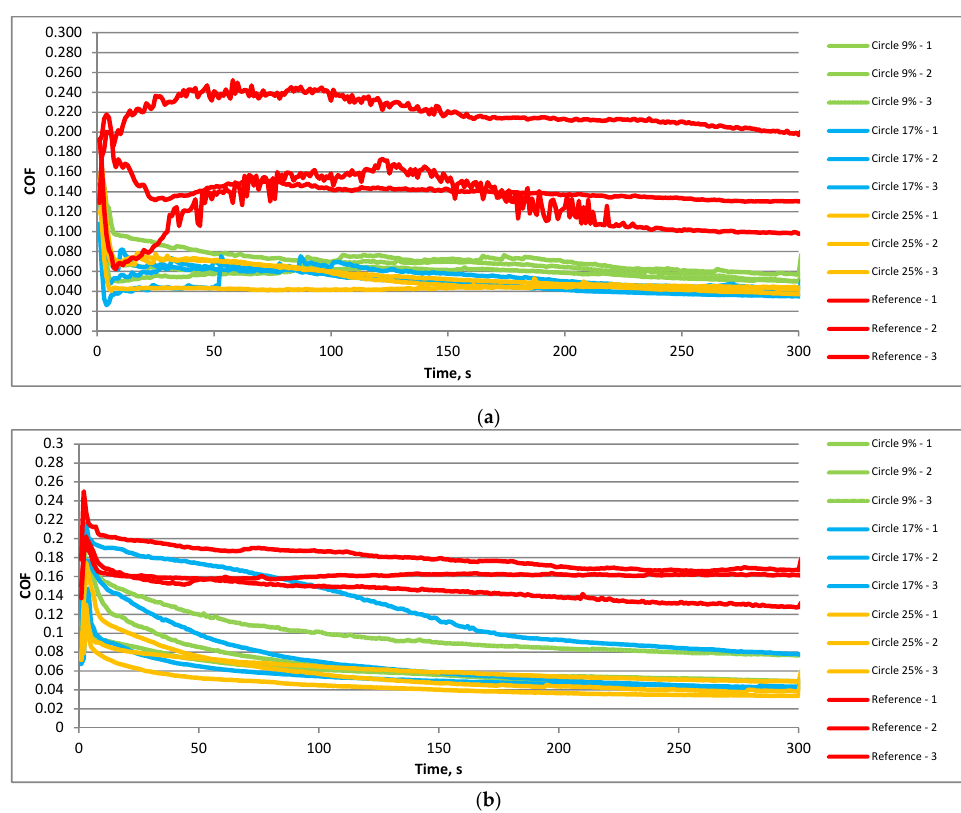
Figure 6. Courses of the coefficient of friction in the following operating conditions: f = 20 Hz; F = 40 N; T = 30 °C ( a ) and f = 20 Hz; F = 80 N; T = 30 °C ( b ). Figure 7 shows the coefficient of friction versus time for textured and untextured assemblies under a higher frequency of oscillation of 40 Hz at a lower temperature of 30 °C. Similarly to working at higher temperatures, an increase in frequency led to an increase in duration of the initial fluctuation of about 30 s, independent of the normal load. For both normal loads, the highest value and the variation of the friction coefficient were obtained for an untextured sliding pair. When textured disc samples were tested, after initial fluctuations, the coefficient of friction was nearly constant. When the load was smaller, namely, 40 N (Figure 7a), all textured sliding pairs behaved similarly. For the higher load of 80 N (Figure 7b), the smallest variation and values of the coefficient of friction were achieved for the sliding pairs with the highest densities of dimples.